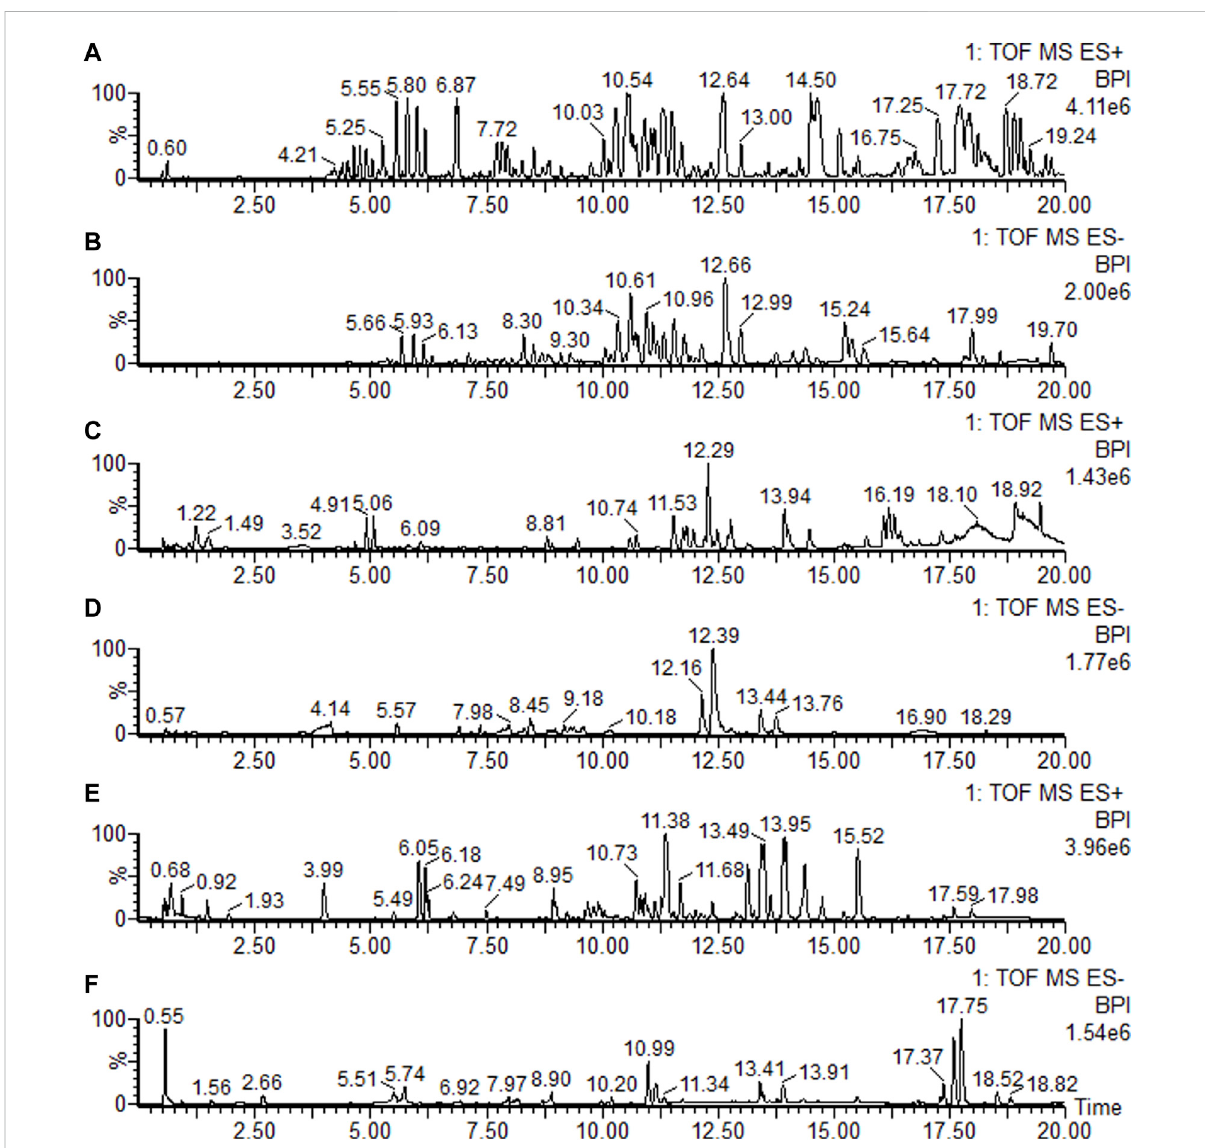
FIGURE 3 Base peak ion current (BPI) chromatograms of the feces, brain, and plasma in positive mode (ES+) and negative mode (ES-), respectively. (A) Feces sample in positive mode; (B) feces sample in negative mode; (C) brain sample in positive mode; (D) brain sample in negative mode; (E) plasma sample in positive mode; and (F) plasma sample in negative